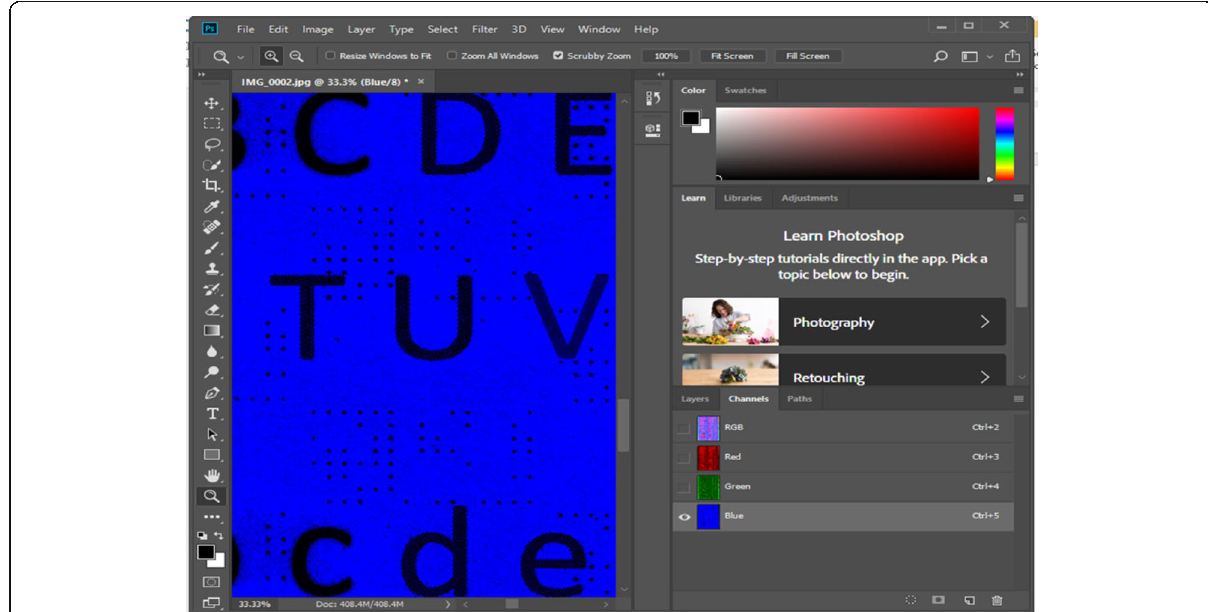
Fig. 6 A blue channel exhibited MIC pattern for a color laser printout of Xerox® brand sample after adjustments in Adobe® Photoshop® CC